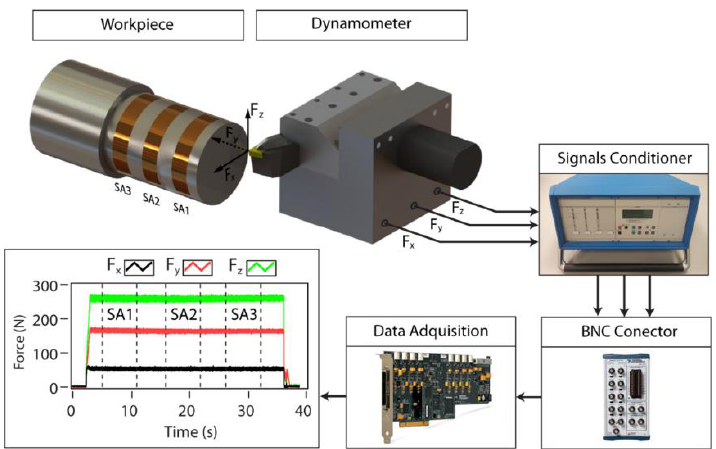
Figure 4. An example for cutting force based indirect tool condition monitoring system [103].